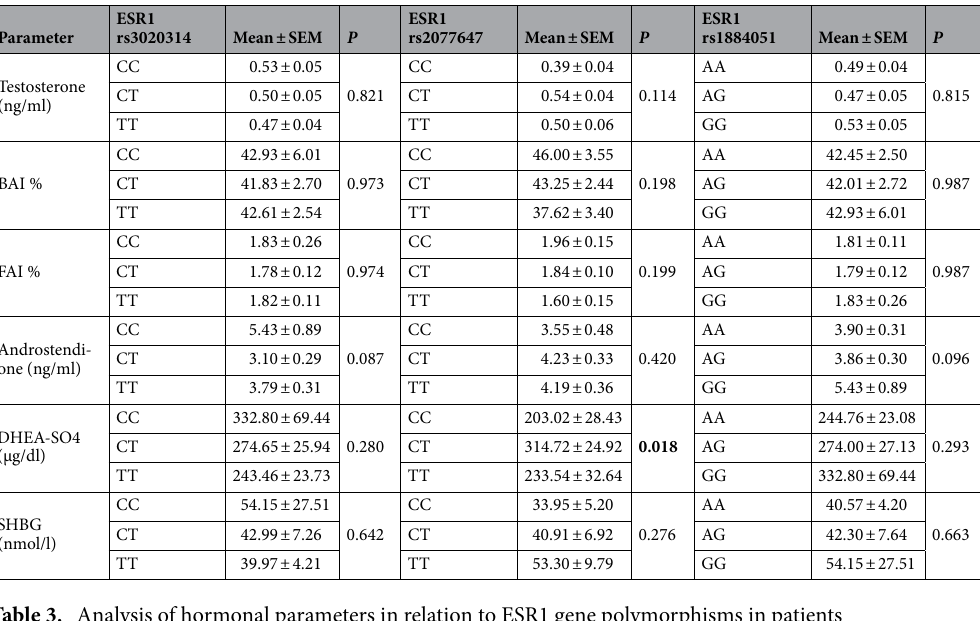
Table 3. Analysis of hormonal parameters in relation to ESR1 gene polymorphisms in patients with hyperandrogenism. BAI% Body Adiposity Index, FAI% Free Androgen Index, DHEA-SO4 dehydroepiandrosterone sulfate, SHGB sex hormone binding globulin. Significant values are given in bold.